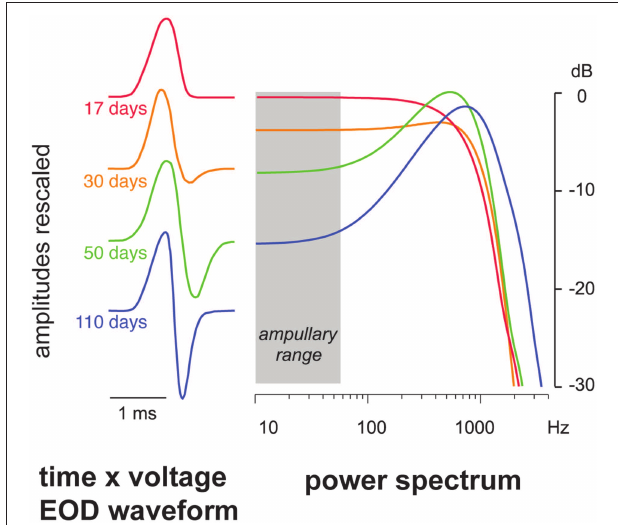
FIGURE 3 | EOD ontogeny of the gymnotiform electric fish Brachyhypopomus gauderio ( Franchina, 1997). The larval fish’s initial EOD is a simple monophasic pulse with abundant energy in the spectral range of the ampullary electroreceptors (gray bar). Over the next 2 months the EOD transforms into a symmetrical biphasic pulse that suppresses the low-frequency spectrum and reduces detectability by ampullary electroreceptors. This transformation should reduce risk of predation from electroreceptive predators. Adapted from Stoddard and Markham (2008) with permission of the